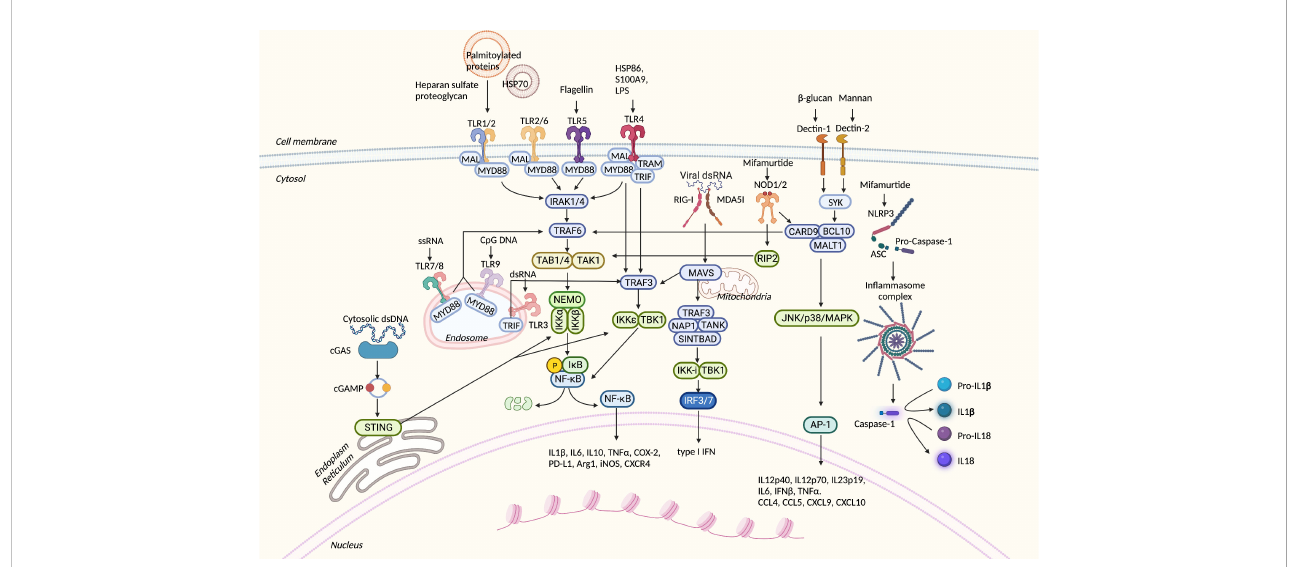
FIGURE 2 Overview of PRR-related signaling pathways in myeloid-derived suppressor cells (MDSCs). PRRs can sense numerous danger signals released by pathogens and damaged normal and neoplastic cells. After binding to proper ligands, PRRs recruit adaptor proteins and trigger downstream signal transduction. These processes result in the translocation of transcription factors into the nucleus, expression of in fl ammatory-related genes, or direct cytokine activation from their inactive forms. PRRs, pattern recognition receptors; TLR, Toll-like receptor; HSP70, heat shock protein 70; LPS, lipopolysaccharide; S100A9, S100 calcium-binding protein A9; MyD88, myeloid differentiation primary TAK-binding proteins 1; IKK, I k B kinase; NEMO, NF- k B essential modulator; Mal, MyD8response 88; RIP2, serine – threonine protein 2; SYK, spleen tyrosine kinase; IRAK4, IL-1R-related kinase 4; TRAF6, TNF receptor-associated factor 6; TAK1, TGF- b -activated kinase 1; TAB1, 8-adapter-like; TRIF, TIR domain-containing adaptor protein-inducing interferon b ; TRAM, TRIF-related adaptor molecule; NOD, nucleotide oligomerization domain; cGAS, cyclic GMP – AMP synthase; cGAMP, 2 ′ 3 ′